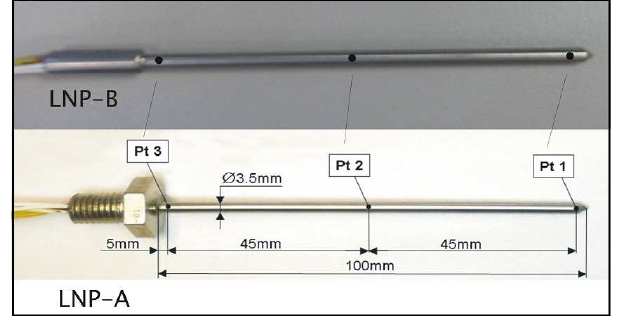
Fig. 2. The custom-made LNP-sensors fabricated by Hukseflux for use on planetary surfaces like on Moon or Mars. They are heated over thewholelength.